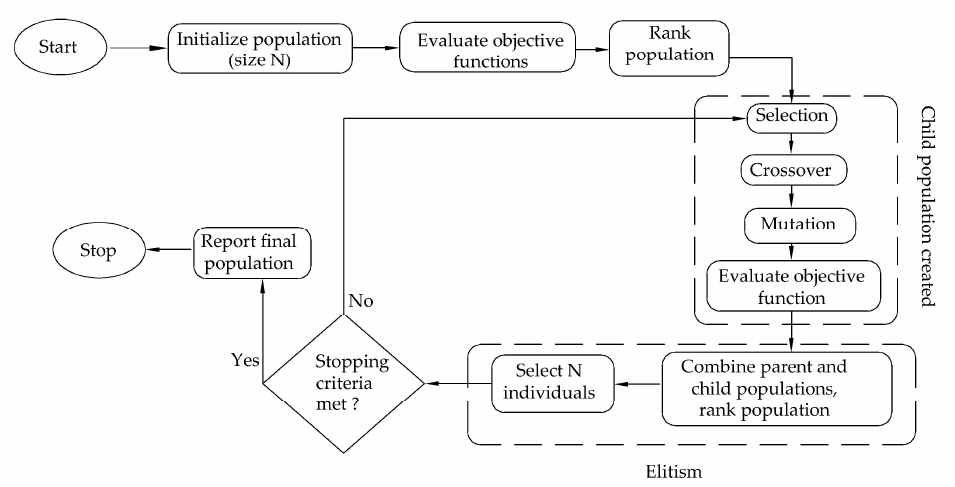
Figure 5. Flowchart of non-dominated sorting genetic algorithm II (NSGA-II).